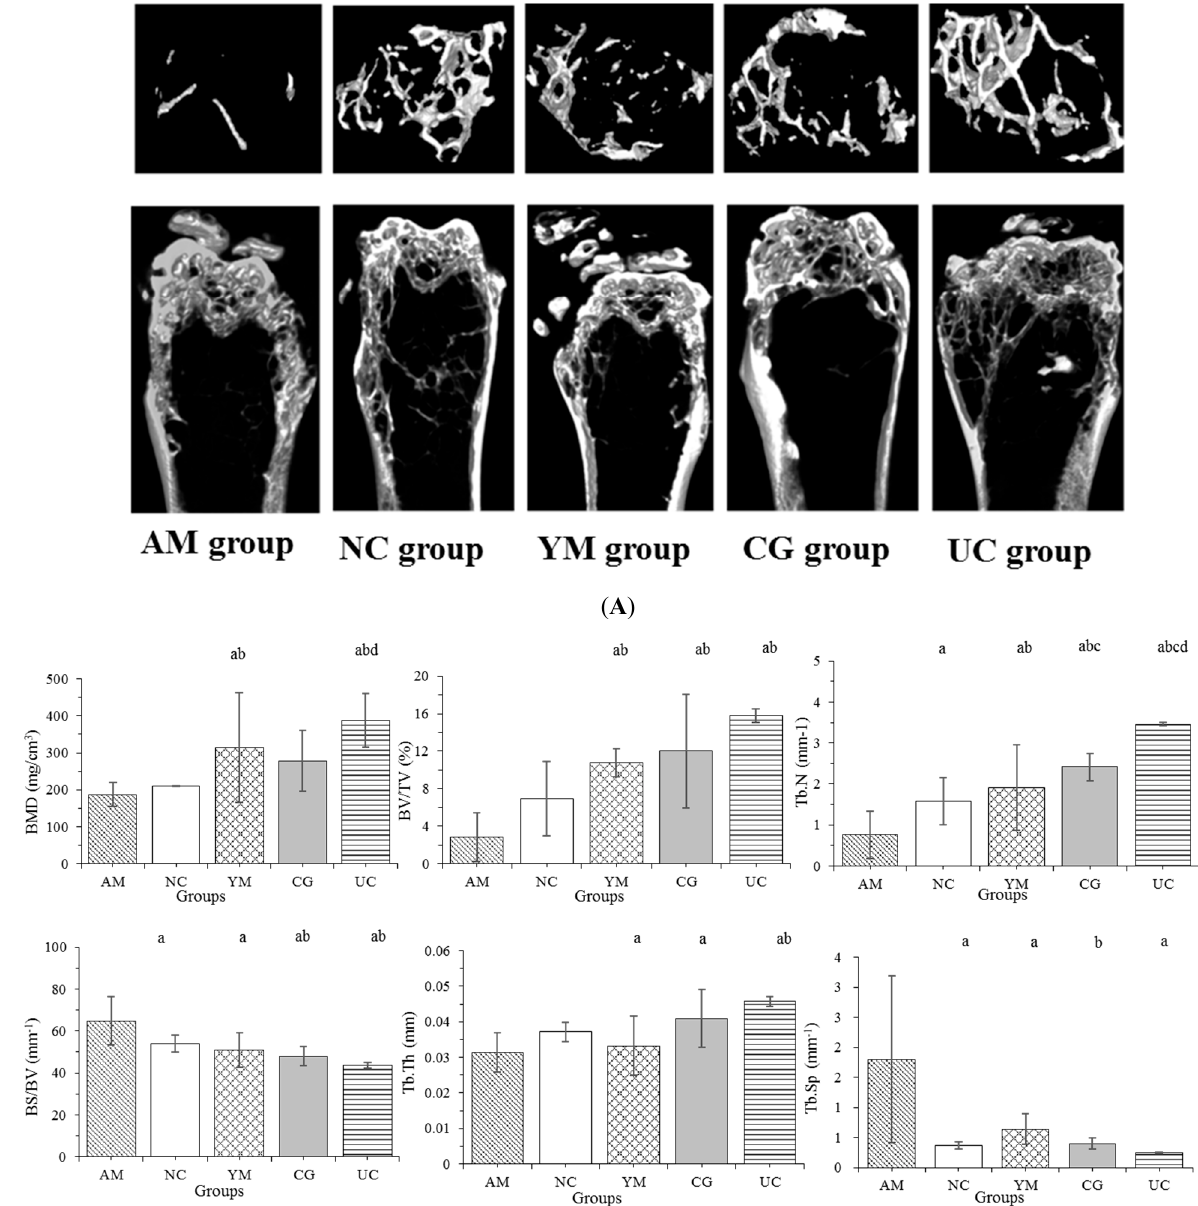
Figure 2. The histomorphometry of the femur in the five groups. ( A ) The images of the changes in bone microarchitecture. ( B ) The mineral density and histomorphometry of the femur. The data are expressed as the means ± SD ( n = 5 in the AM group, n = 7 in the YM, CG, NC, and UC groups); a p < 0.05 versus the AM group, b p < 0.05 versus the NC group, c p < 0.05 versus the YM group, d p < 0.05 versus the CG group.